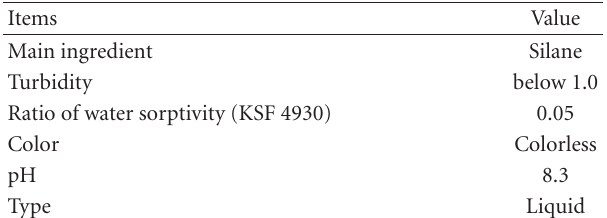
Table 1: Material properties of penetrant